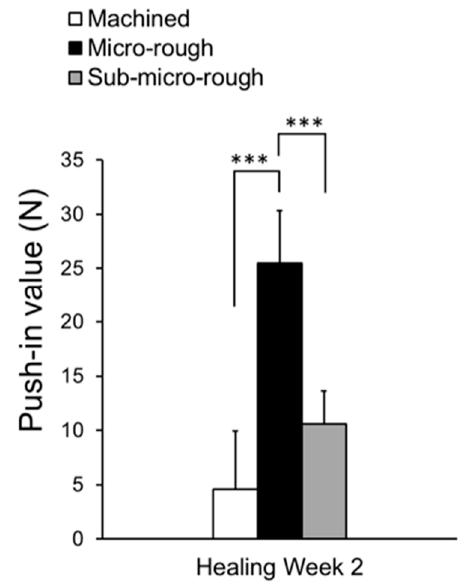
Figure 5. The strength of implant anchorage in bone, evaluated by the biomechanical push-in test in a rat femur model. Each bar represents mean ± standard deviation of machined ( n = 5), micro-rough ( n = 5), or sub-micro-rough ( n = 5) titanium. *** p < 0.001, one-way ANOVA followed by Tukey’s test.